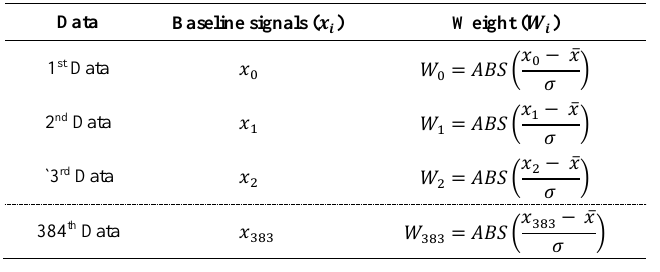
Table 1. Illustration of the normalization process in the baseline EEG signal